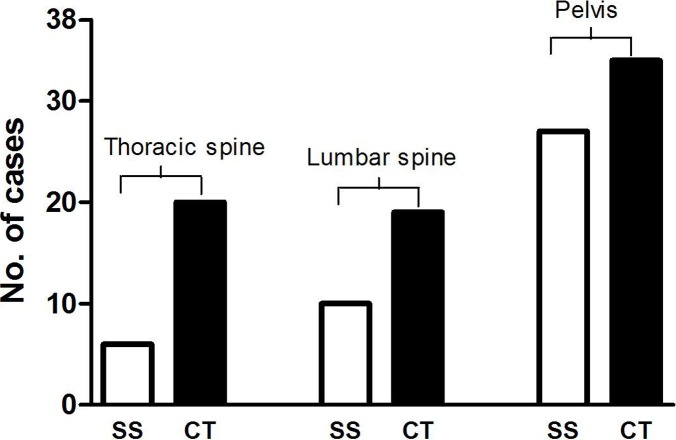
Comparison of the number of patients with bone lesions revealed by SS and CT.